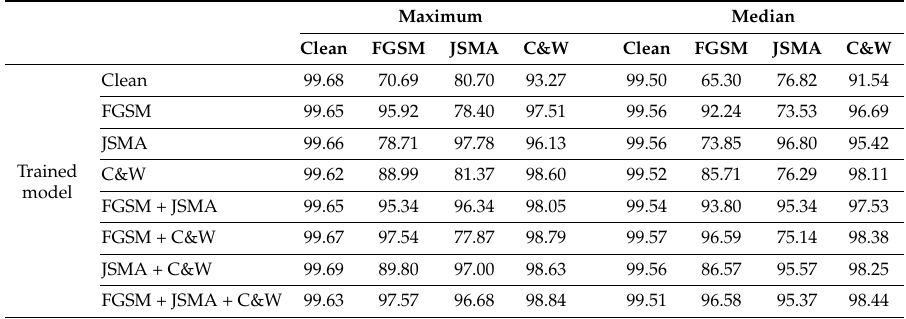
Table 3. Test accuracy of ResNet18 measured between 40 and 100 epochs. The network is trained with data augmentation including random rotation, random translation and random